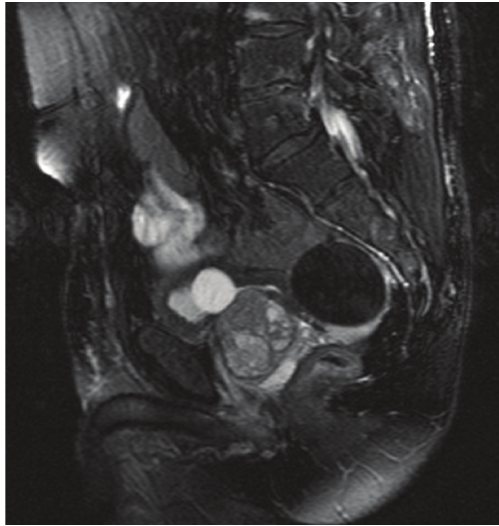
Figure 1: T2-weighted (fat-suppressed) sagittal image of the pelvis reveals a 5.5cm retrovesical lesion lying anterior to the rectum. It is well circumscribed. There is no pelvic sidewall lymphadenopathy.